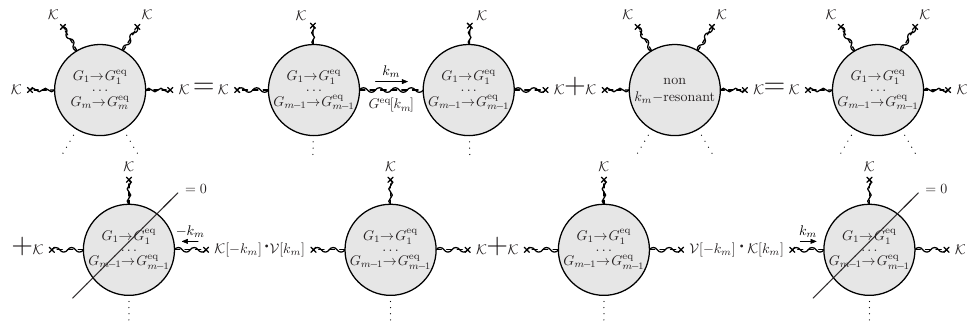
Figure 3: The relation by which the equivalence of the G eq propagator is